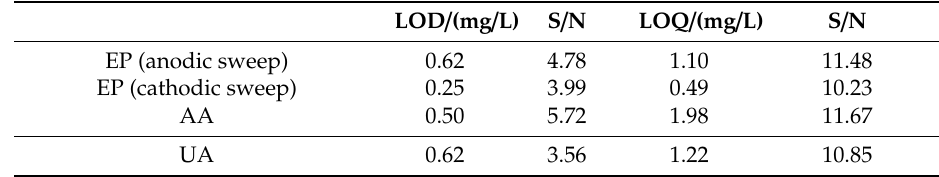
Table 1. Summary of LOD and LOQ values determined by each SWV method along with the obtained S / N values.